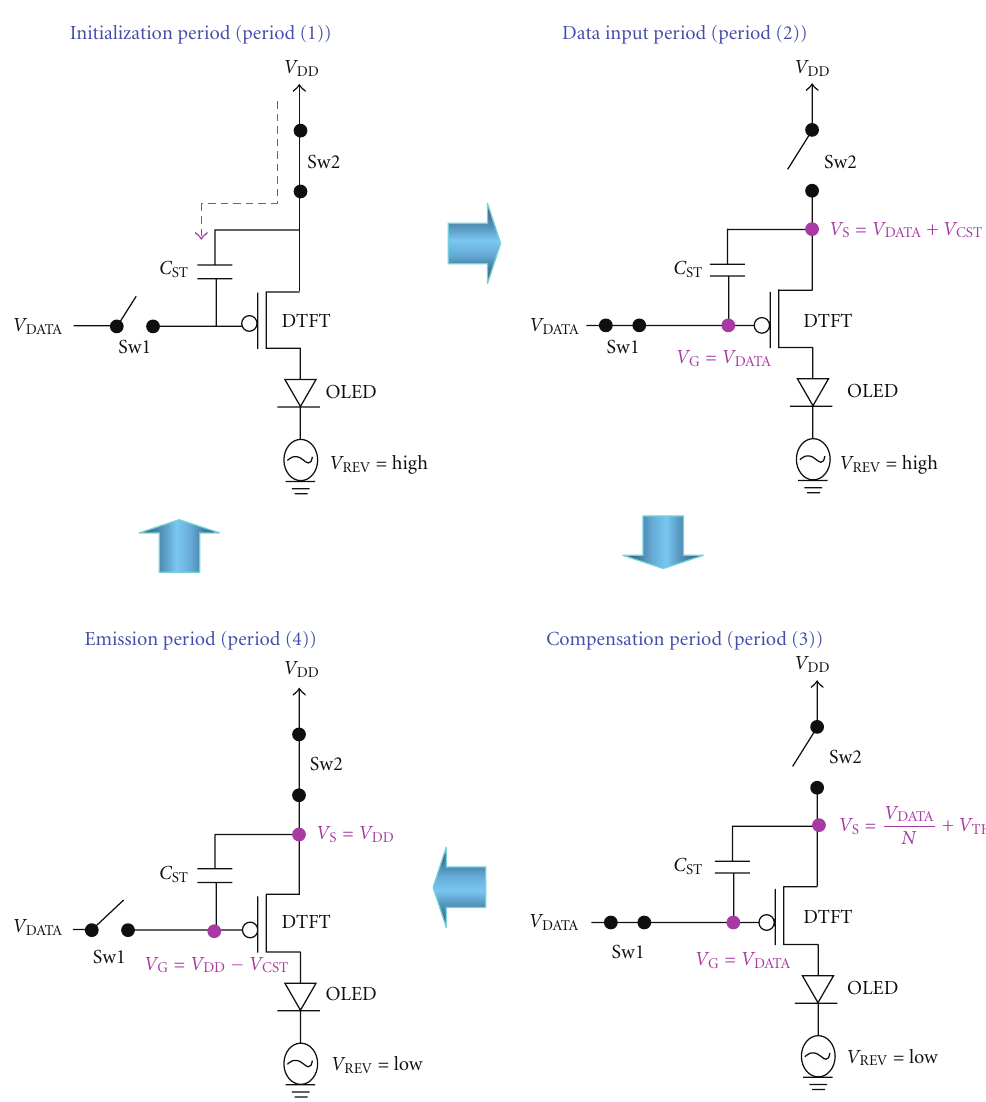
Figure 2: Equivalent circuit in each state of